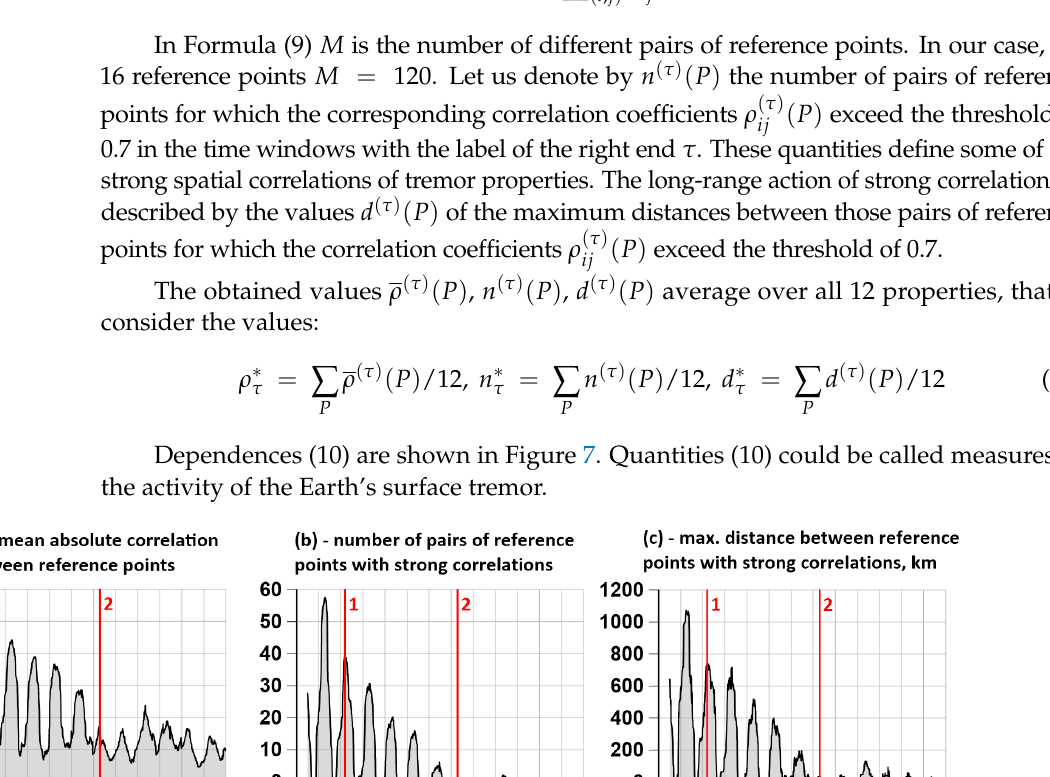
In Formula (9) M is the number of different pairs of reference points. In our case, for 16 reference points M = 120. Let us denote by n ( τ ) ( P ) the number of pairs of reference ( τ ) ( P ) exceed the threshold of points for which the corresponding correlation coefficients ρ ij 0.7 in the time windows with the label of the right end τ . These quantities define some of the strong spatial correlations of tremor properties. The long-range action of strong correlations is described by the values d ( τ ) ( P ) of the maximum distances between those pairs of reference ( τ ) ( P ) exceed the threshold of 0.7. points for which the correlation coefficients ρ ij The obtained values ρ ( τ ) ( P ) , n ( τ ) ( P ) , d ( τ ) ( P ) average over all 12 properties, that is,